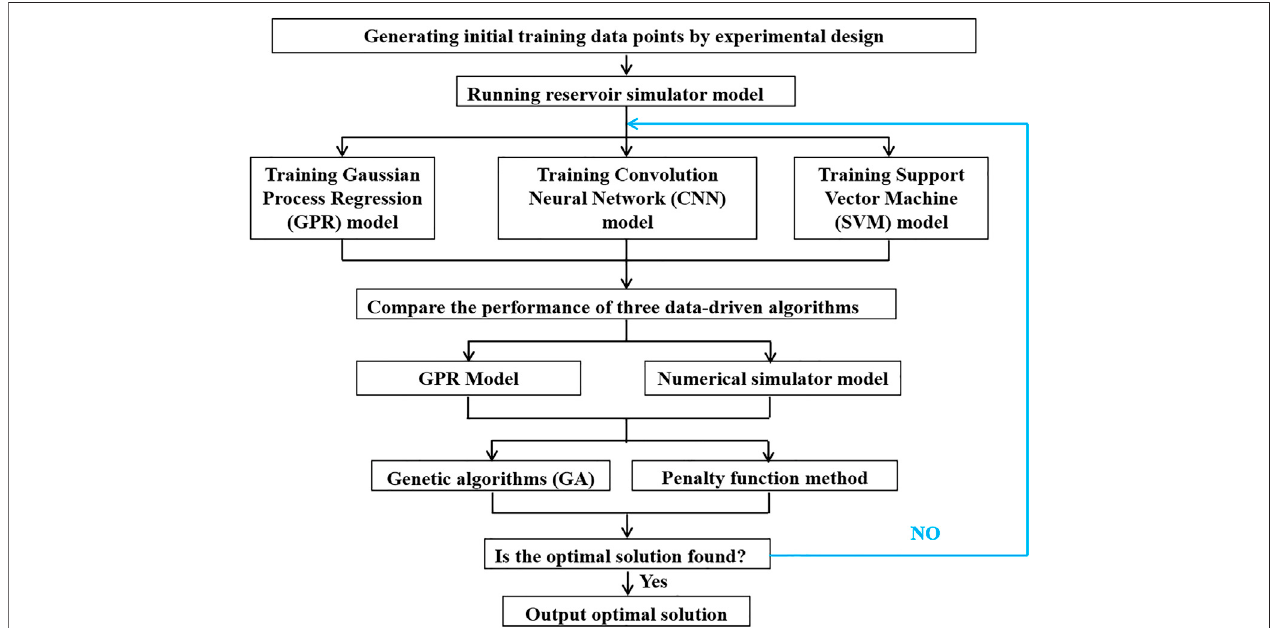
FIGURE 4 | Flowchart of the optimization algorithm.